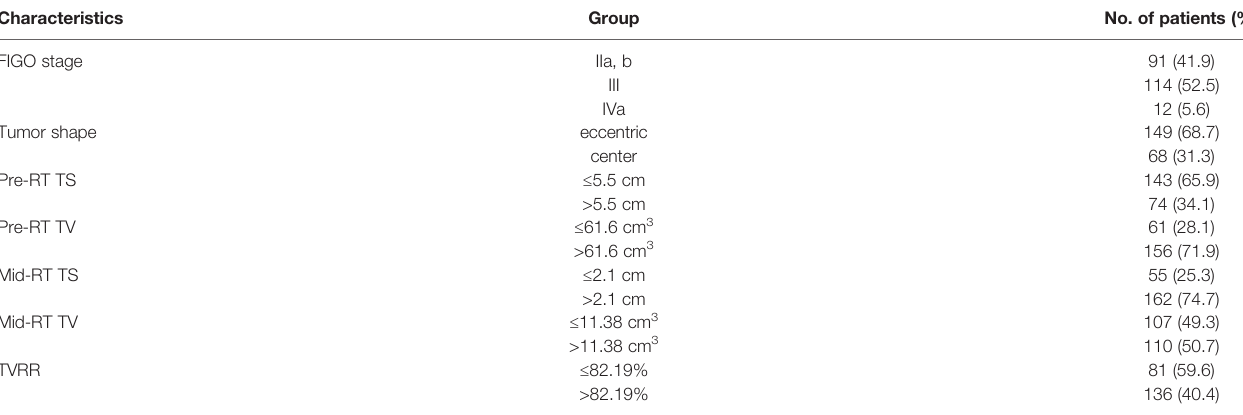
FIGO, International Federation of Gynecology and Obstetrics; RT, radiotherapy; TS, tumor size; TV, tumor volume; TVRR: tumor volume reduction rate.